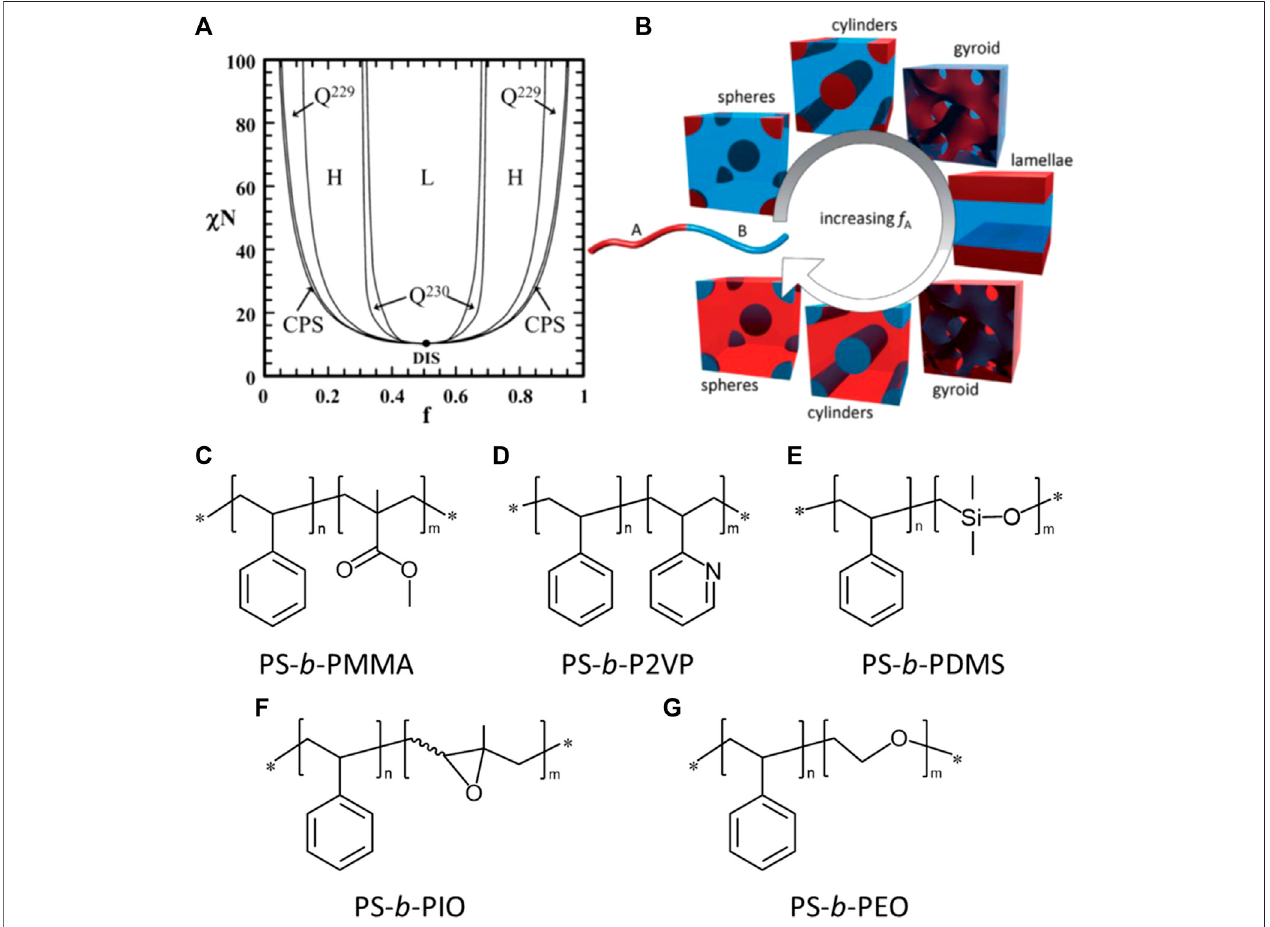
FIGURE 1 | (A) Phase diagram of PS- b -PMMA system, indicating regions of interaction parameter ( χ ) and volume fraction ( f ) that give rise to formation of different morphologies where L: lamellae, H: hexagonally packed cylinders, Q230: double gyroid phase, Q229: body-centered spheres, CPS: closed-packed spheres, and DIS: disorderedphase (B) representsevolutionofdifferentmorphologiesasvolumefractionofcomponentAisincreased.(Reproducedfromref.1) (C – G) chemicalstructures of various commonly used block copolymers that are addressed throughout this manuscript.